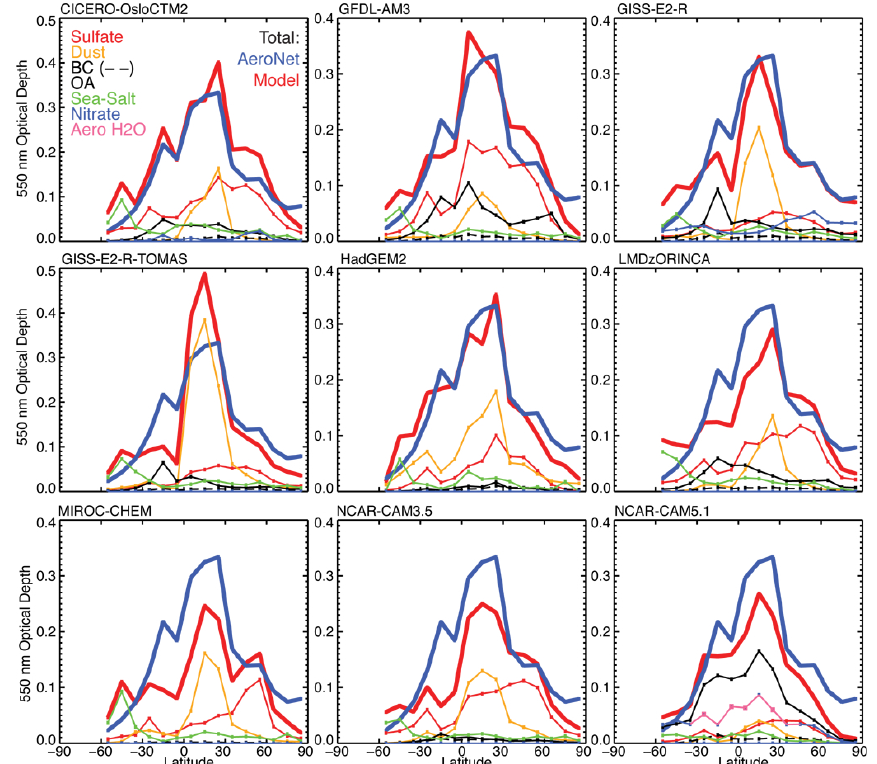
Fig. 5. Zonal mean annual average total AOD in AeroNet observations and models (thick lines) along with AOD by aerosol component (thin lines). Aero H 2 O is aerosol water in NCAR-CAM5.1. Clear-sky AOD is used for the GISS-E2-R model. Table 5. Correlation and bias of modeled AAOD with respect to OMI observations. Model R vs. OMI NMB vs. OMI R vs. OMI NMB vs. OMI global global 90 ◦ S to 60 ◦ N 90 ◦ S to 60 ◦ N CICERO-OsloCTM2 0.35 − 55 0.60 − 49 CSIRO-Mk3.6 0.35 − 52 0.58 − 47 GFDL-AM3 0.31 0.39